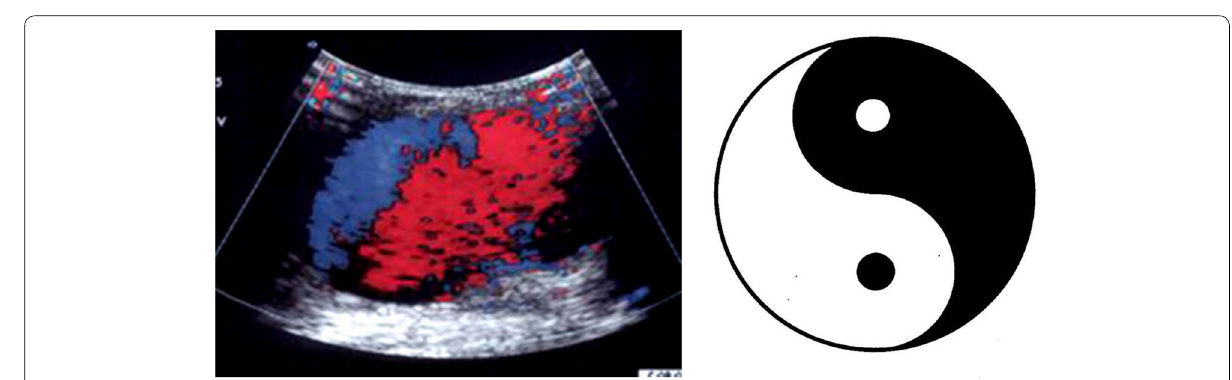
Fig. 13 Pseudoaneurism: color Doppler aspect: colorized yin yang